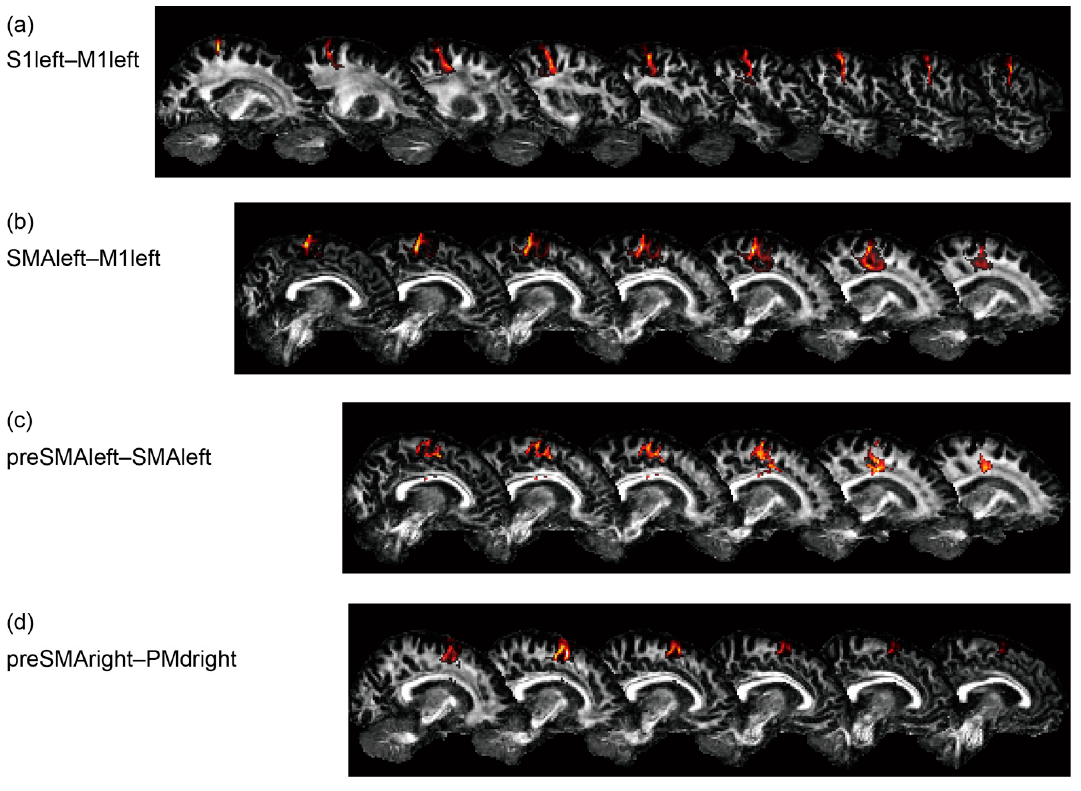
Figure 4. Reconstruction results of probabilistic tractography for a representative participant. ( a )